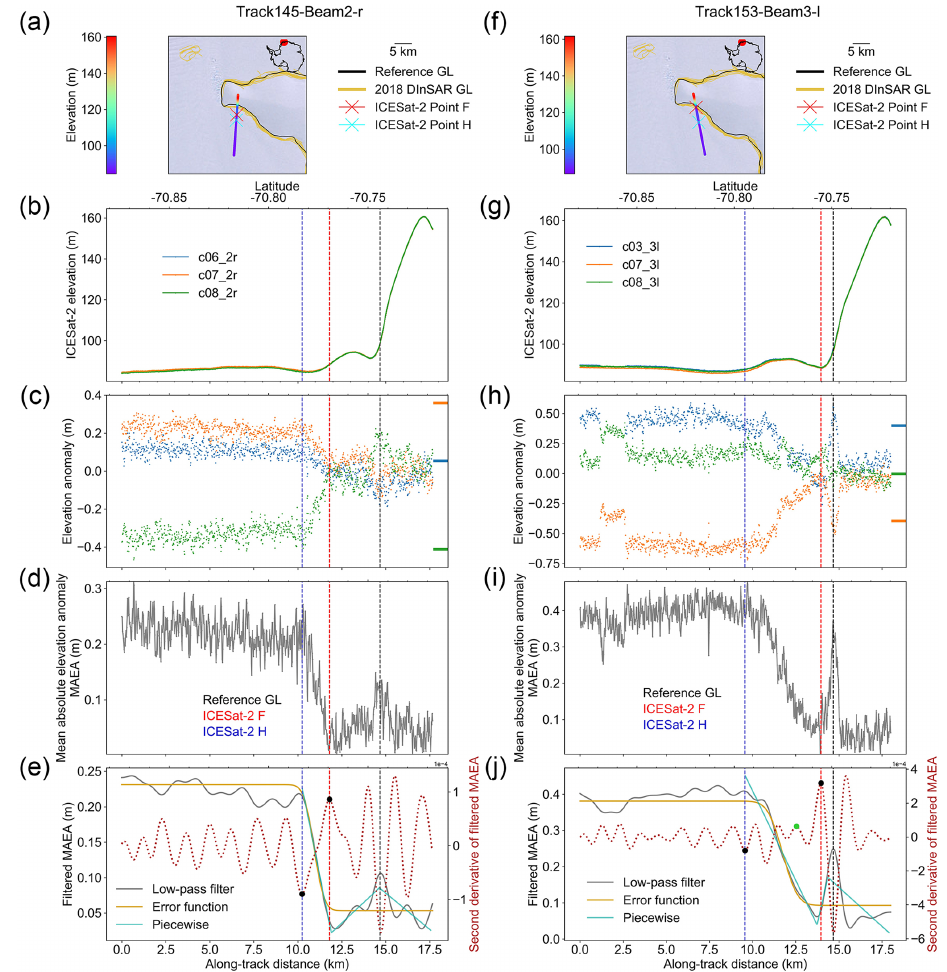
Figure 9. Comparison between the inland limit of tidal flexure (Point F) from repeat-track analysis for two tracks located in the same region on the Dronning Maud Land under different ocean tidal amplitude ranges. Same as Fig. 3, (a) – e) show ICESat-2 repeat-track analysis for three right beams from repeat cycles 6, 7, and 8 in beam pair 2 of track 145. (f–j) ICESat-2 repeat-track analysis for three left beams from repeat cycles 3, 7, and 8 in beam pair 3 of track